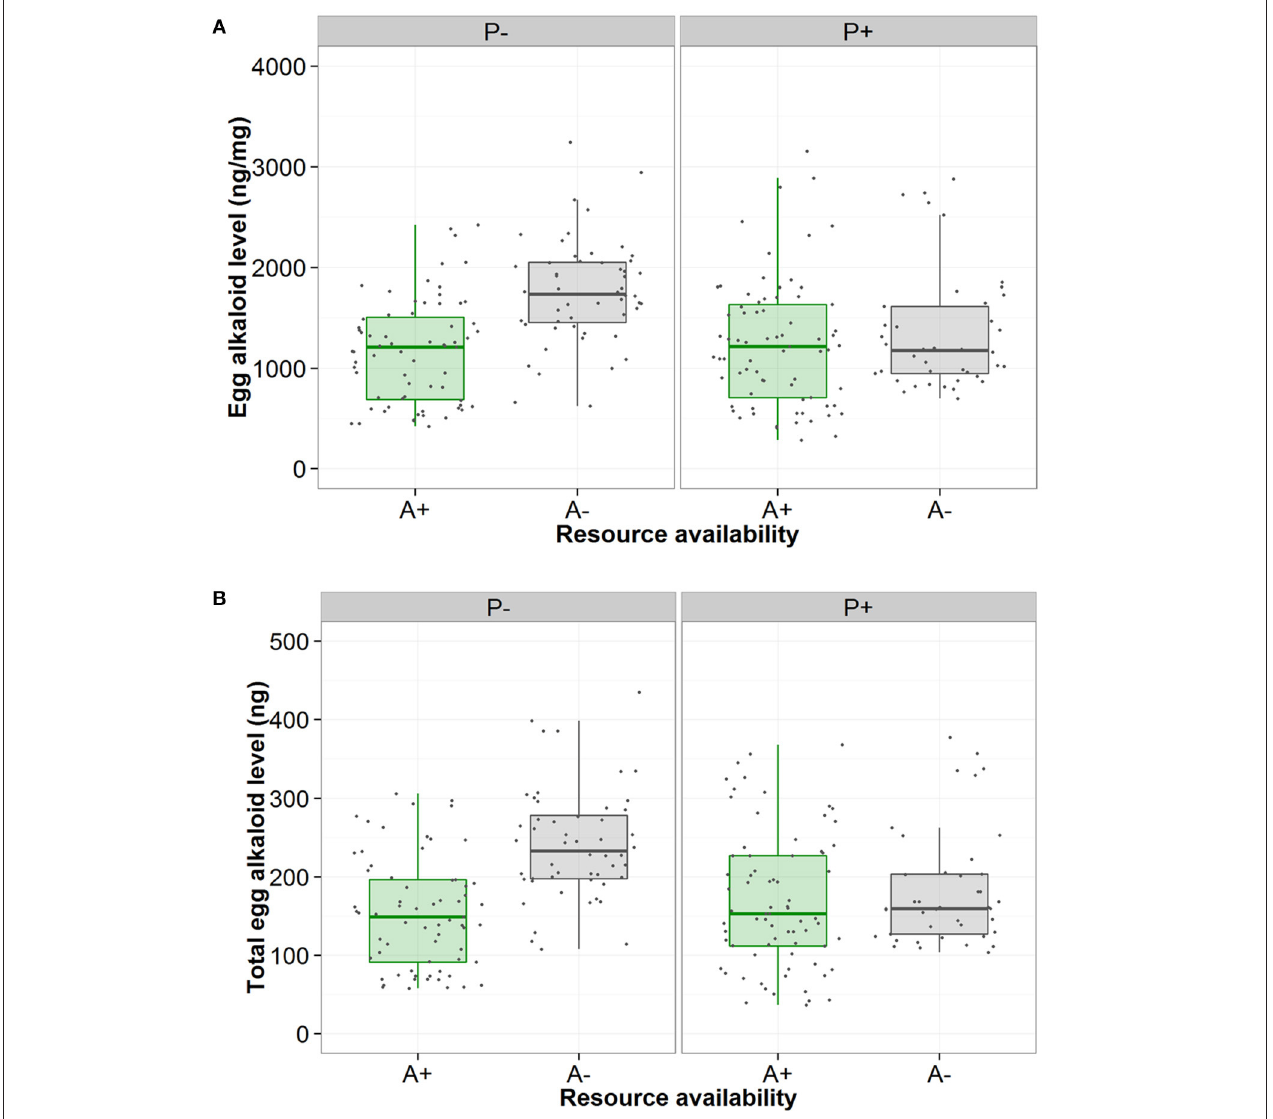
FIGURE 3 | Effect of no perceived predation risk (P − ) or perceived predation risk (P + ) and aphid presence (green/A + ) or absence (gray/A − ) on (A) the concentration of the alkaloid (-)-adaline in A. bipunctata eggs (ng/mg) and (B) the total level of the alkaloid (-)-adaline in A. bipunctata eggs